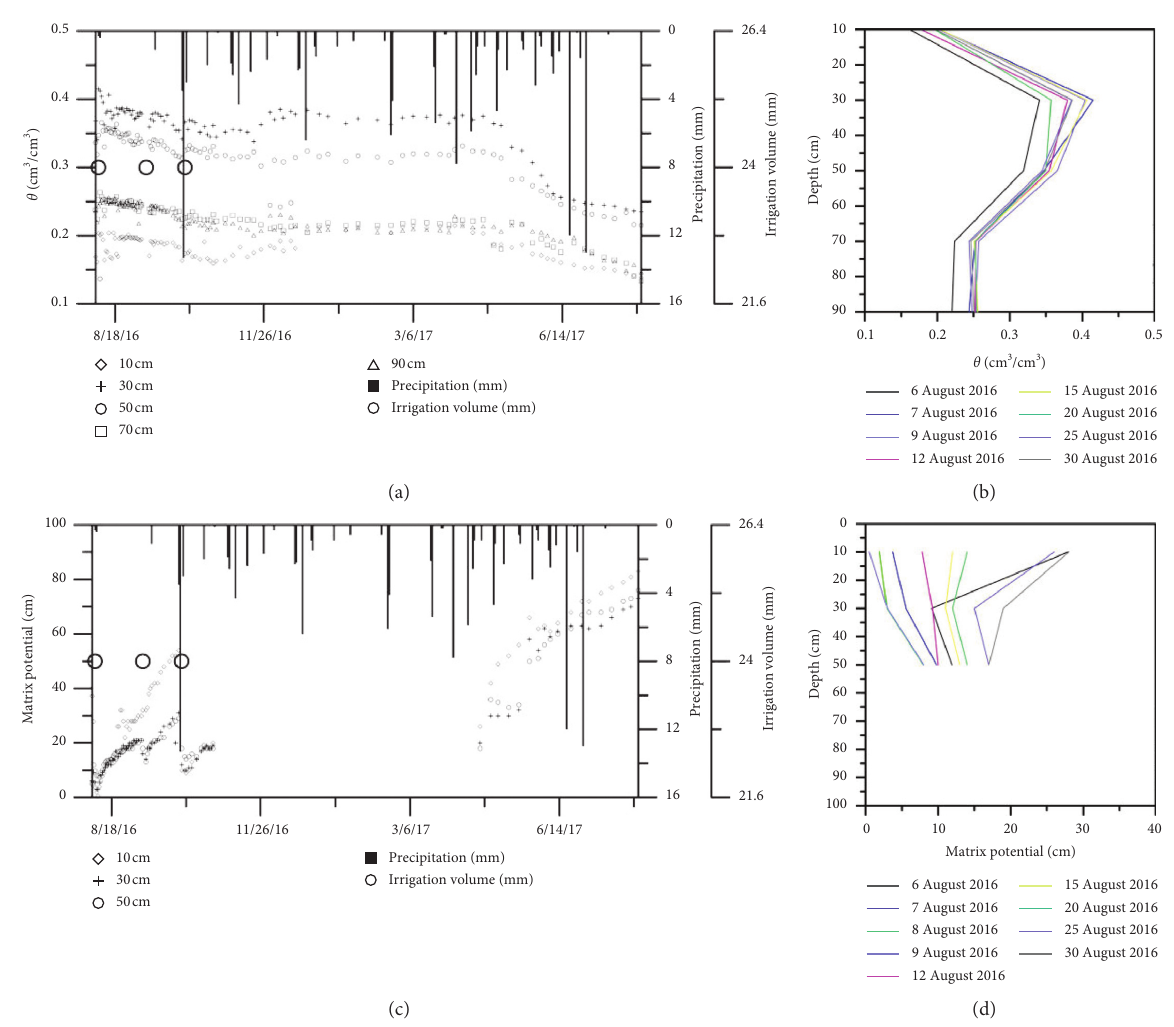
Figure 6: Water distribution in soil with a thickness of 50cm with uncompaction: (a) water distribution at different depths; (b) response of water content to irrigation; (c) matrix potential at different depths; (d) response of matrix potential to